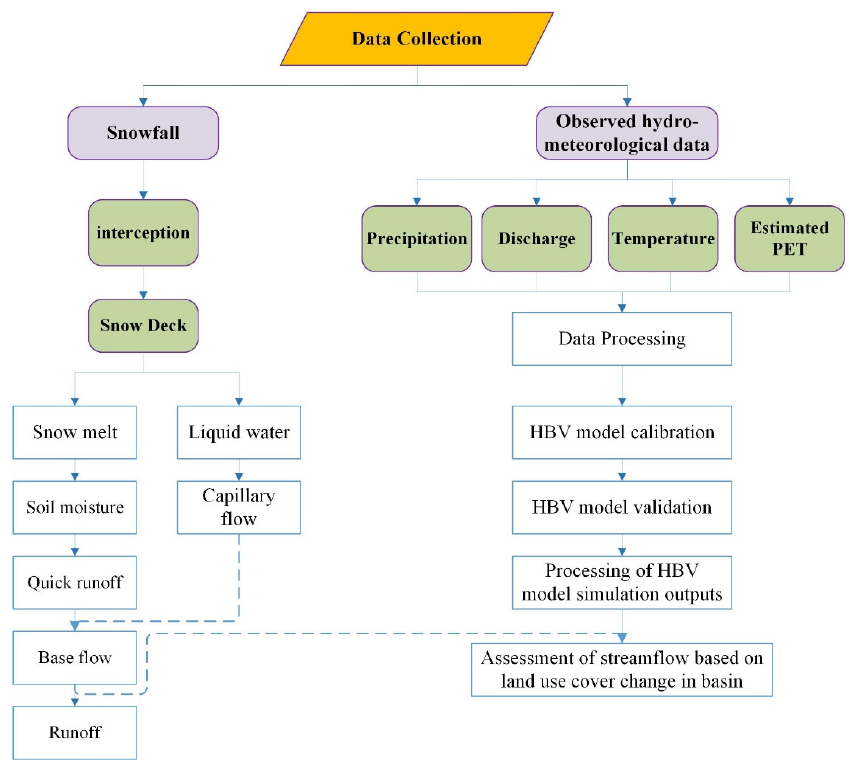
Figure 2. Data and methodology flowchart of the HBV model.